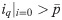
A. Changes in profits and revenue when iqq < 0 and iq|i=0>p¯. B. Changes in profits and revenue when iqq < 0 and iq|i=0≤p¯.